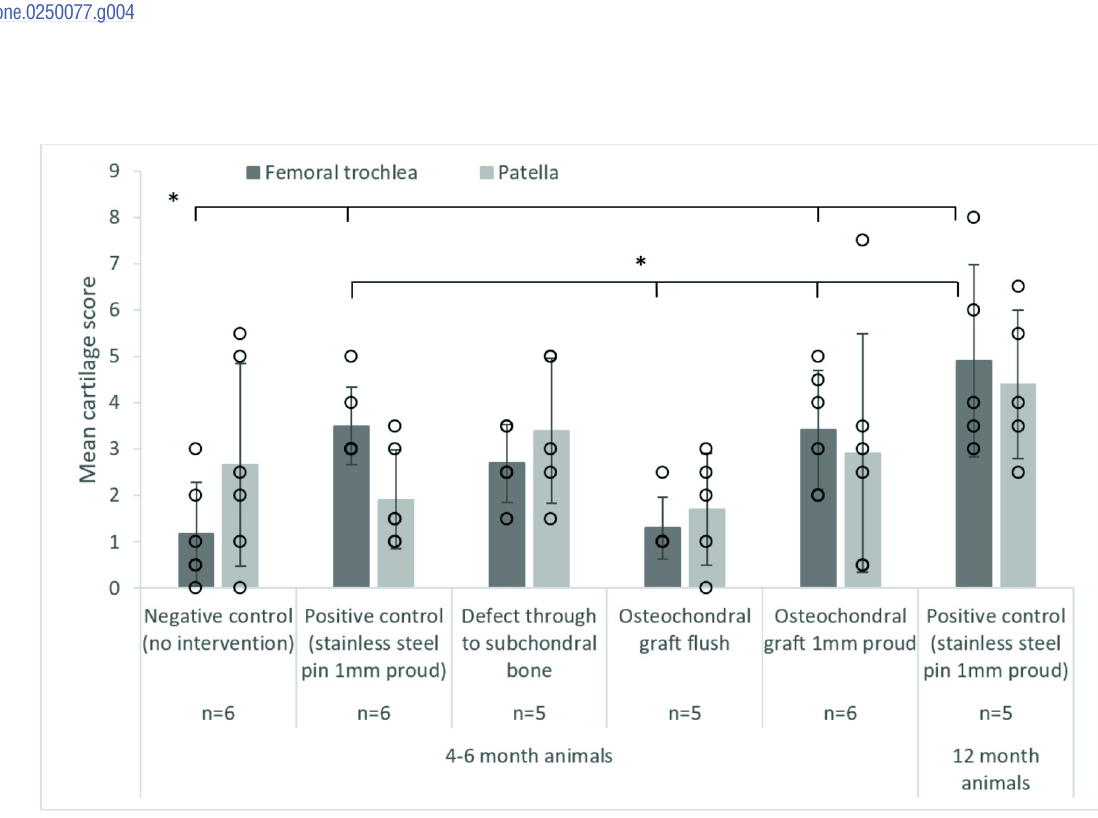
PLOS ONE | https://doi.org/10.1371/journal.pone.0250077 April 26,